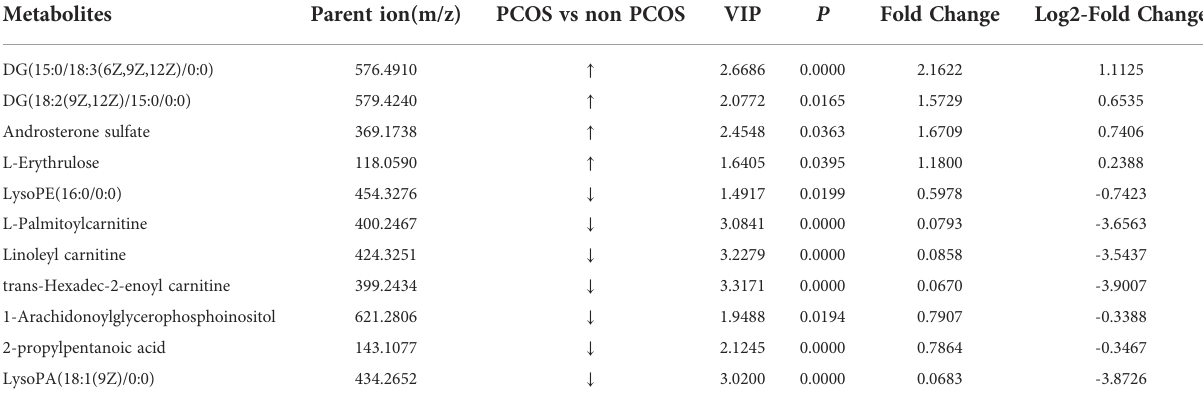
TABLE 1 Characteristics of the differential metabolites of women with PCOS in follicular fl uid. Metabolites Parent ion(m/z) PCOS vs non PCOS Fold